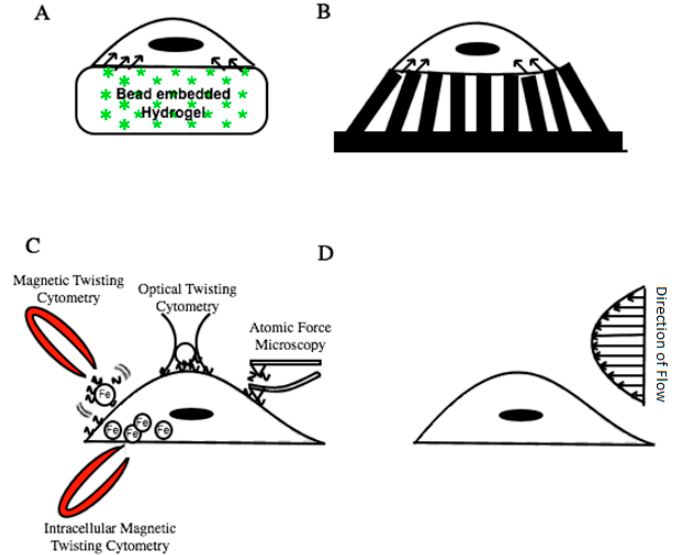
Figure 2. Common biophysical tools used to investigate mechanotransduction. ( A , B ) The Traction Force Microscopy set up quantifies the displacement in the substrate caused by the cell. Cells are grown on protein-functionalized ( A ) hydrogels embedded with fluorescent markers; or ( B ) micropillars with known height and elastic moduli. The deflection ( Δ l of a region of the hydrogel or pillar) is indirectly used to quantify cell contractility in that zonal area; ( C ) Magnetic or optical twisting cytometry and atomic force microscopy are techniques that can apply pico to micro Newton shear, compressive and tensile forces on cell receptors, and cytosolic organelles; ( D ) Shear forces from fluid flow are investigated by growing cells on tubular or cylindrical surfaces. The apical surface of the cell experiences shear forces that is proportional to flow velocity shear rate and viscosity.